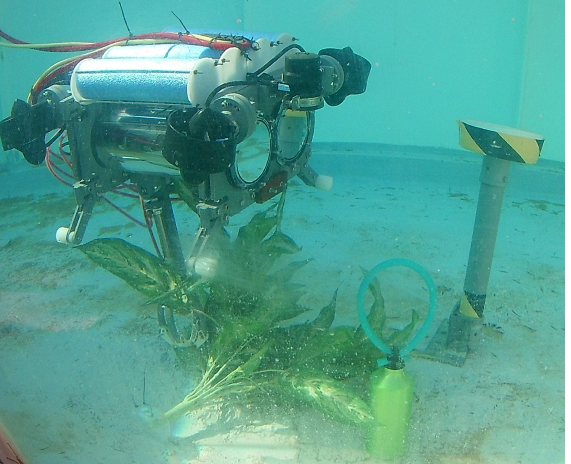
Figure 1. The UDrobot picking up a plant in an underwater